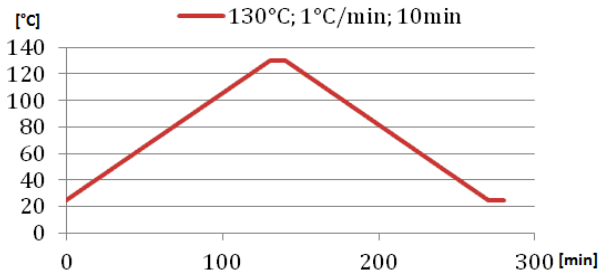
Fig. 2. Plots of testing profiles. Table 2. Testing profile 1 (170 ◦ C, 3 ◦ C min − 1 , 30 min).